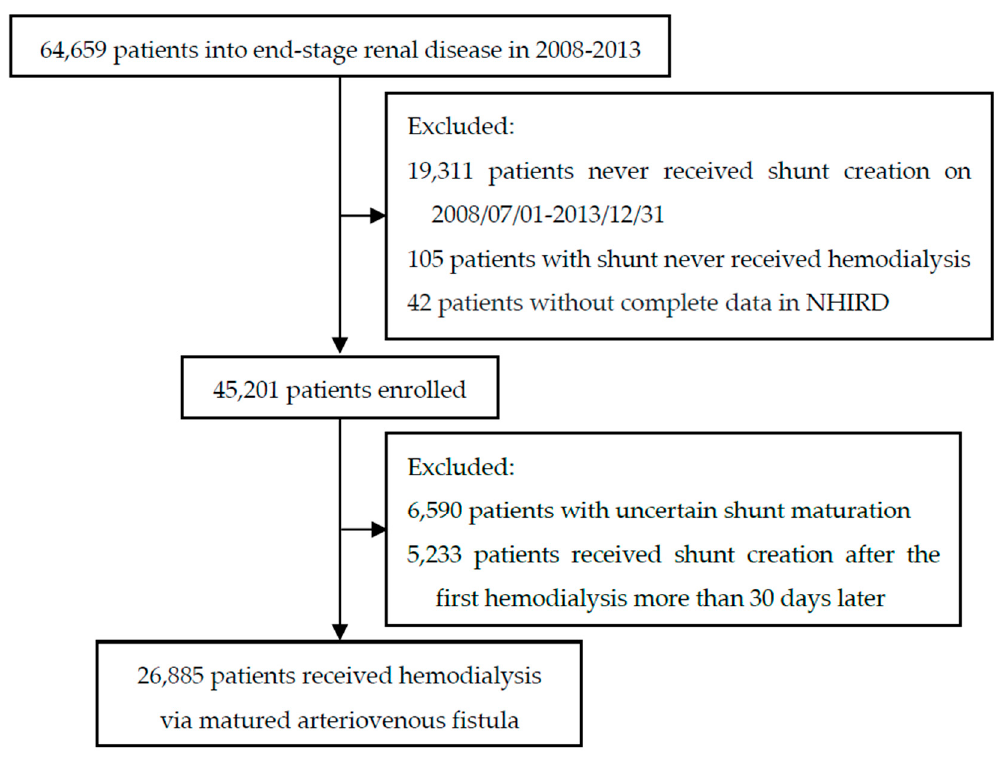
Figure 1. Flow chart of patients enrolled from National Health Insurance Research Database (NHIRD)